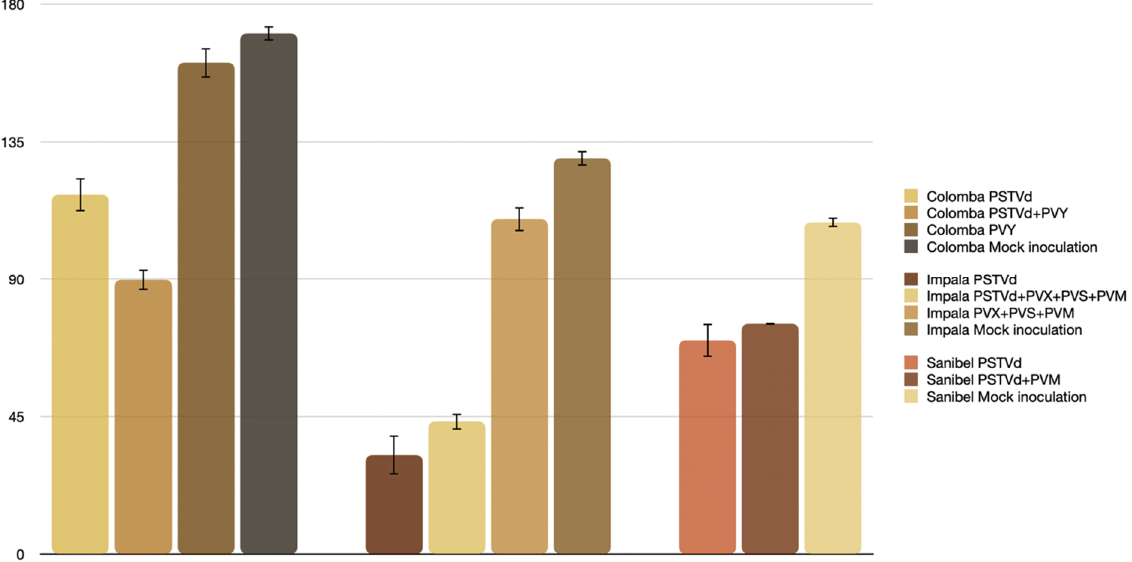
Figure 13. Mean weight of tubers per plant infected with PSTVd (strain NickTr-3), viral-infected, and viroid/viral-mixed infected of three potato cultivars. According to Student’s t -test with Bon- ferroni correction ( p < 0.05) for the cv. Colomba differences significant between mock- and PSTVd-infected and mixed PSTVd + PVY-infected plan ts for the cv. Impala between mock-, PSTVd-, and PSTVd + PVX + PVS + PVM-infected plants for the cv. Sanibel between mock- and PSTVd-infected plants.